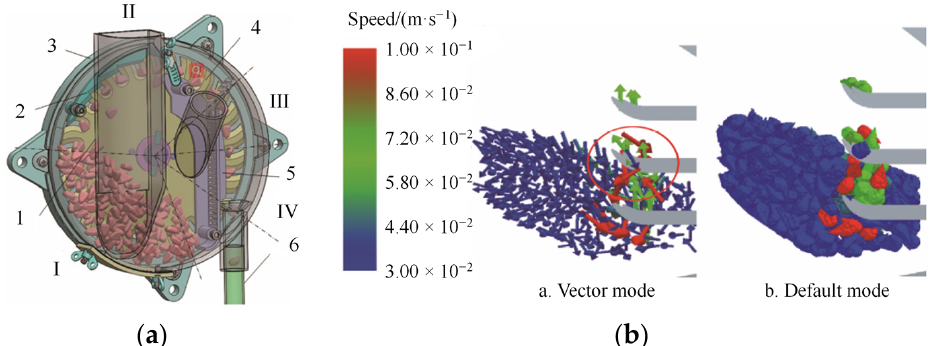
Figure 8. Typical seed metering process simulation. ( a ) Seeding filling process of a maize seed metering device [166]; ( b ) Seed taking process of a garlic metering device [171]. 1.Upper shell. 2. Seed cleaning device. 3. Lower shell. 4. Metering disc. 5. Seed pushing board. 6. Seed delivery tube. I. Seed filling zone. II. Seed cleaning zone. III. Seed guidance zone. IV. Seed pushing